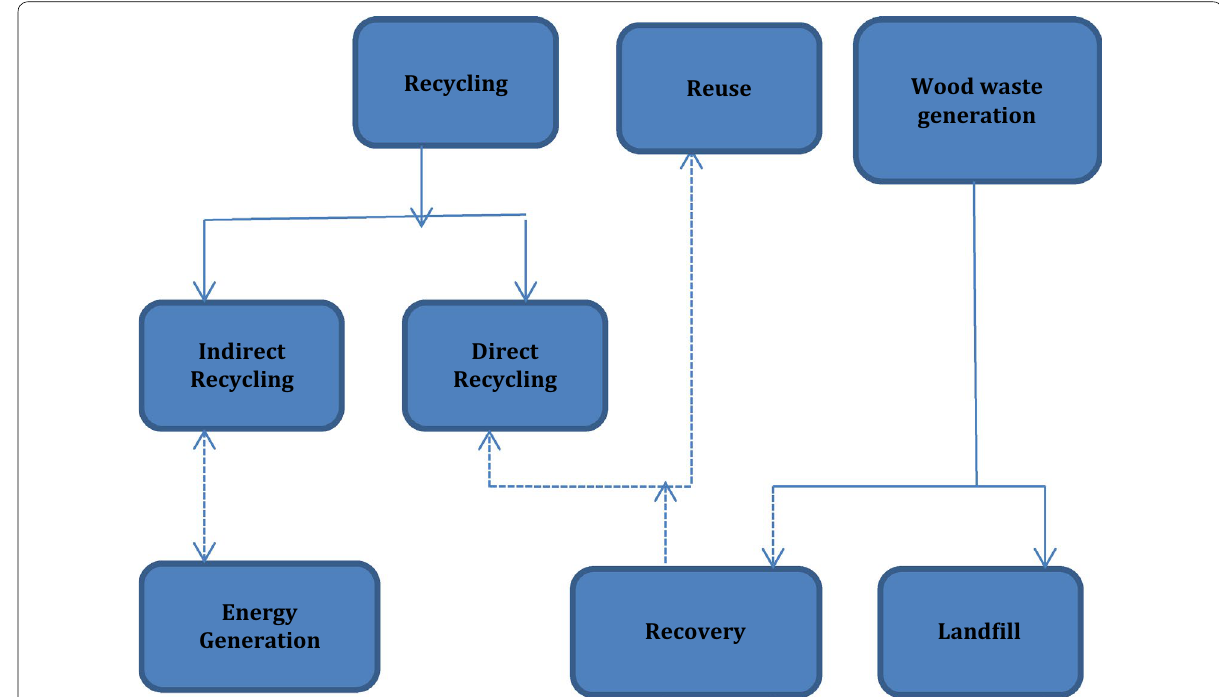
Fig. 3 Schematic flow of recycling, reuse and recovery of wood products. Modified from Taylor and Warnken